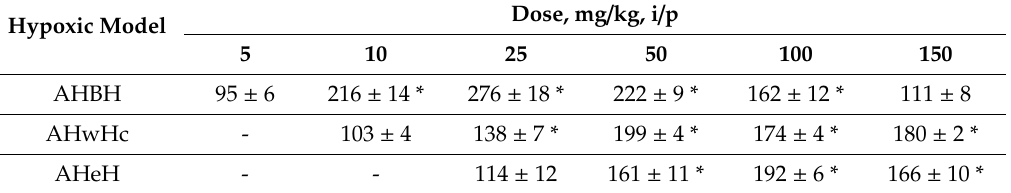
Table 1. E ff ect of administration (i / p) of Acyzol on the lifespan of mice during acute hypoxia. Hypoxic Model